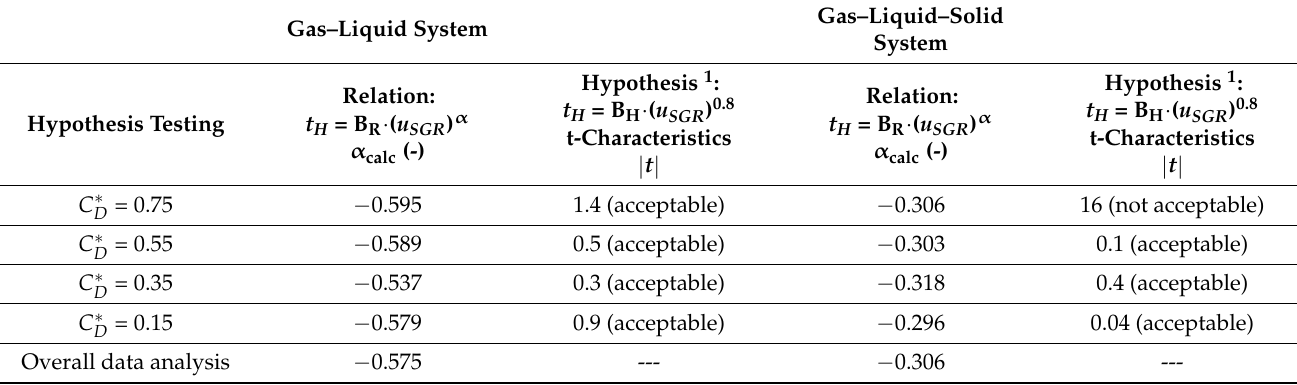
Table 10. Homogenization time t H : Results of the hypothesis testing for effect of riser superficial velocity u SGR for deflector clearance C ∗ = const. D